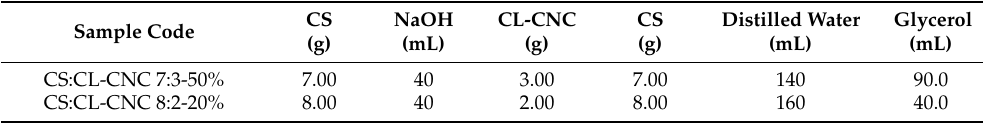
Table 1. Composition of the cellulose nanocrystals, starch, and glycerol used in the investigation of the development of